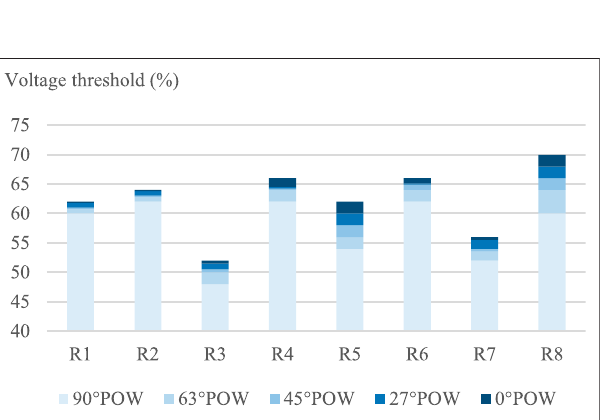
FIGURE 9 | Voltage threshold of different VTCs under different POW (0 °